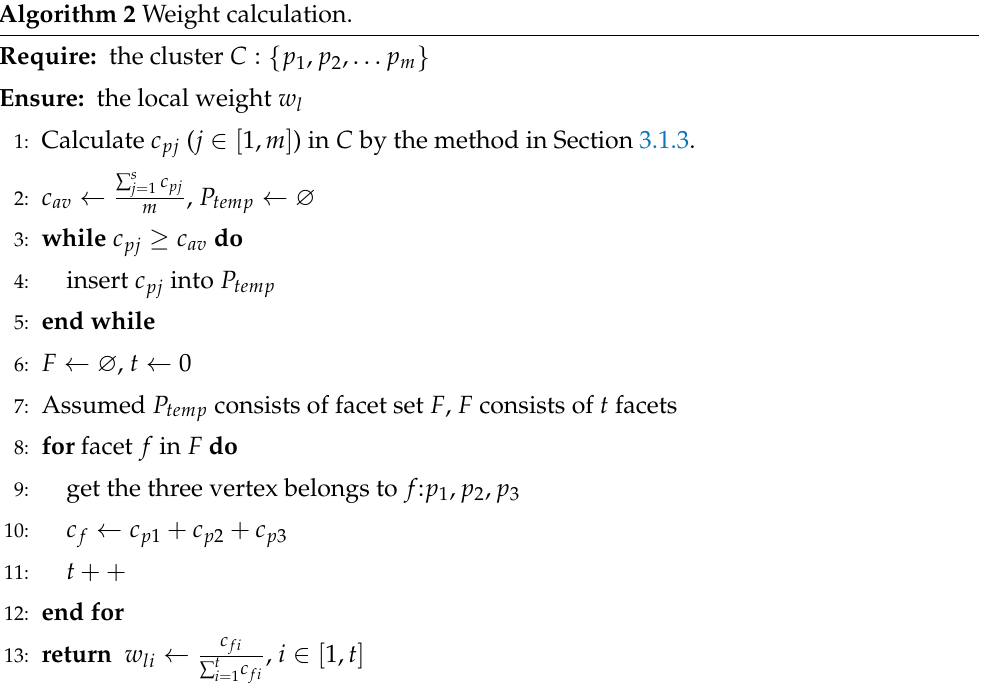
Algorithm 2 Weight